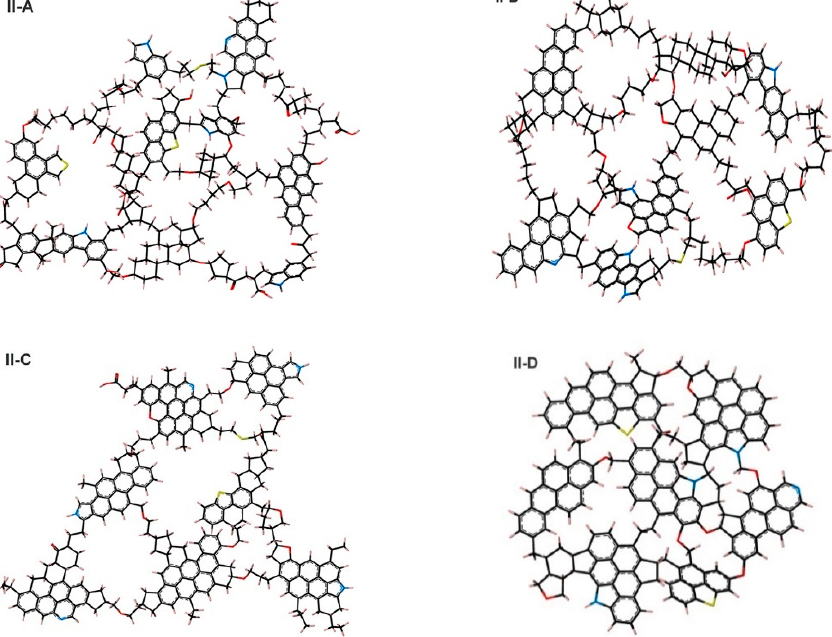
Figure 5. Six kerogen units developed by Ungerer et al. [91], representative of real kerogen macro- molecules before structural optimization. A single atomic unit of kerogen (also known as macro- molecule) comprised of carbon (black), oxygen (red), sulfur (yellow), nitrogen (blue), and hydrogen (gray).